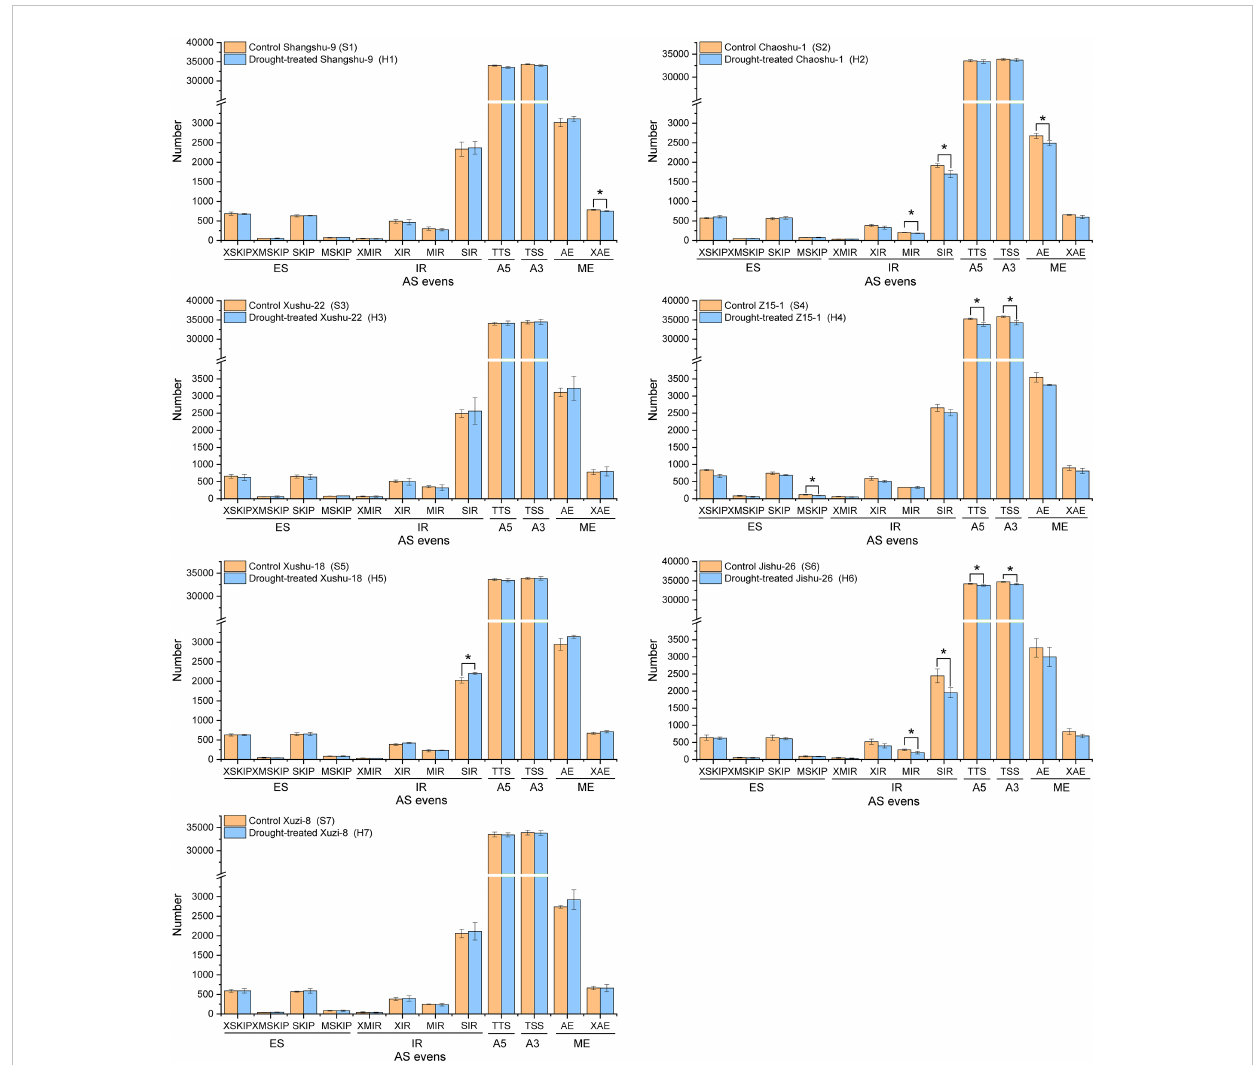
FIGURE 2 Identi fi cation of Alternative splicing (AS) events of different sweet potato cultivars. TSS, transcription start site (or alternative 5 ’ fi rst exon, A5); TTS, transcription terminal site (or alternative 3 ’ last exon, A3); SKIP, skipped exon (SKIP_ON, SKIP_OFF pair); XSKIP, approximate SKIP (XSKIP_ON, XSKIP_OFF pair); MSKIP, Multi-exon SKIP (MSKIP_ON, MSKIP_OFF pair);XMSKIP, Approximate MSKIP (XMSKIP_ON, XMSKIP_OFF pair); SIR, Single intron retention (IR_ON, IR_OFF pair); XIR, Approximate IR (XIR_ON, XIR_OFF pair); MIR, Multi-IR (MIR_ON, MIR_OFF pair); XMIR, Approximate MIR (XMIR_ON, XMIR_OFF pair); AE, Alternative exon ends (5 ’ , 3 ’ , or both); XAE, Approximate AE; ES, exon skip, including SKIP, XSKIP, MSKIP and XMSKIP; IR, Intron retention, including SIR, XIR, MIR and XMIR; ME, mutually exclusive exon, including AE and XAE. The symbol * means error bars represent the average of three replicates ± SE (* p < 0.05; **p <